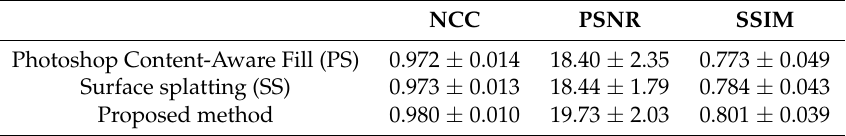
Table 2. Mean and standard deviation of all methods in the similarity measure